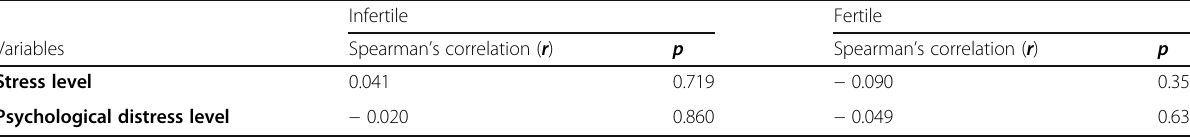
Table 2 Correlation between stress, psychological distress, and AMH among infertile and fertile women